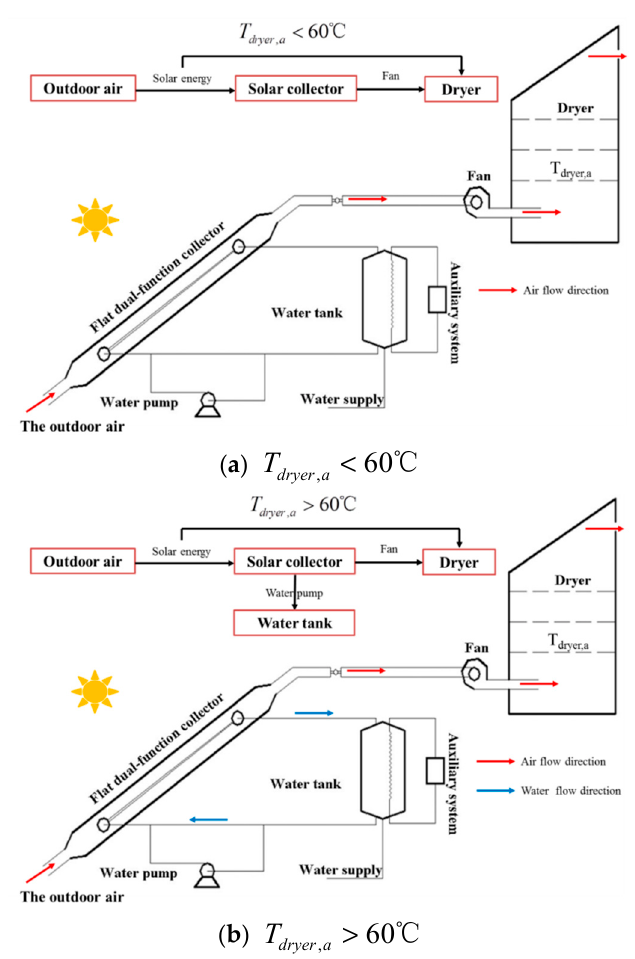
Figure 1. The schematic diagram of hybrid solar dryer operation.